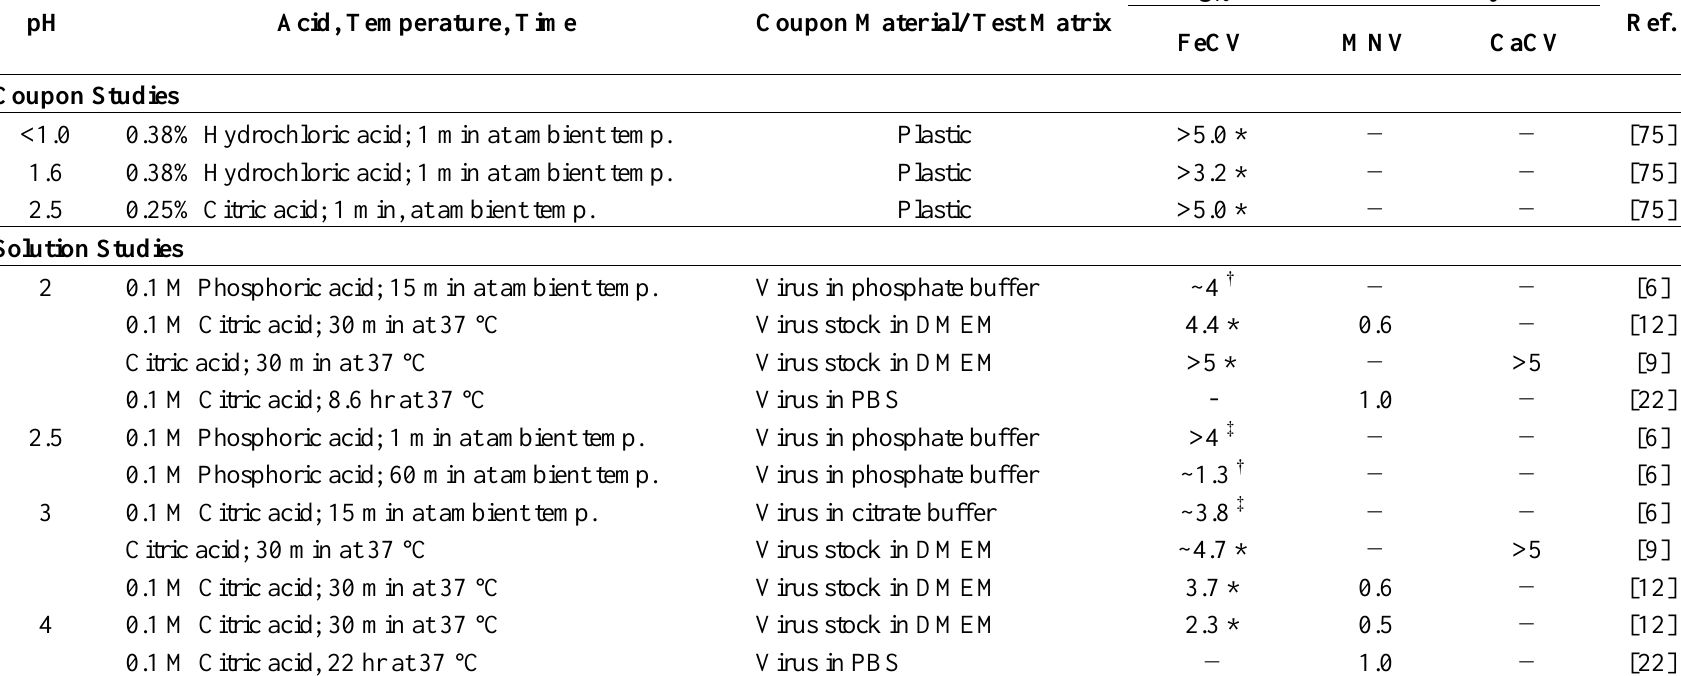
Table 9. Low pH inactivation of